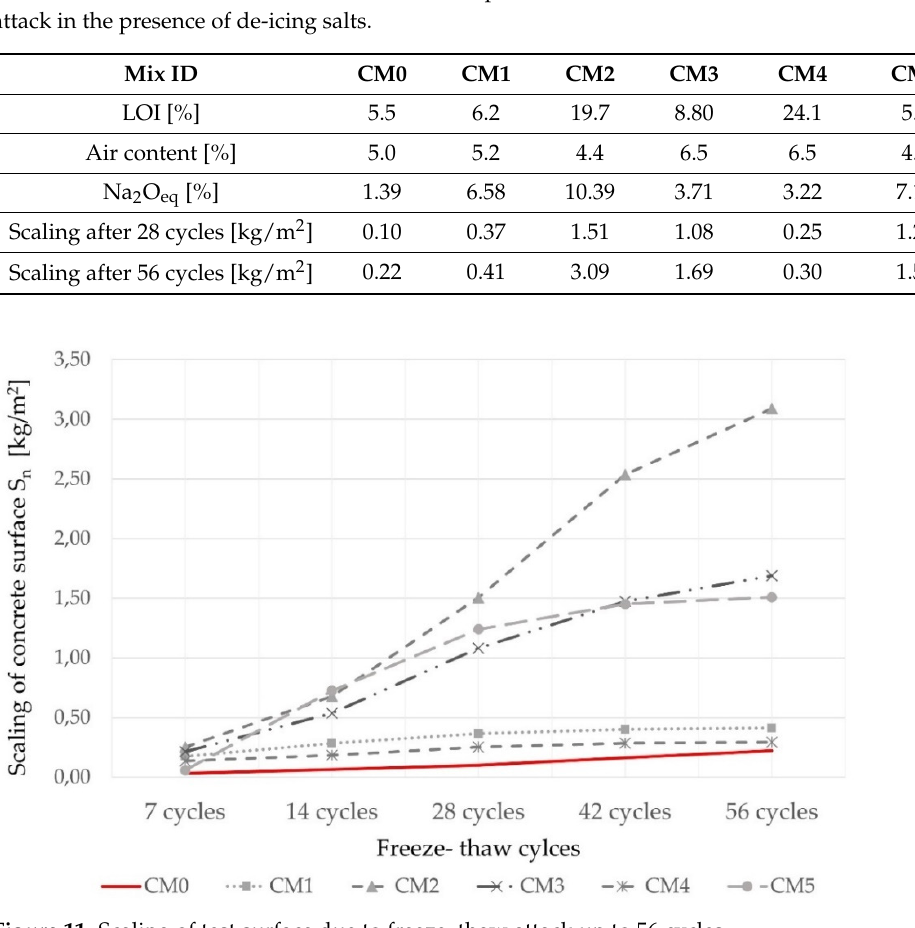
Figure 11. Scaling of test surface due to freeze–thaw attack up to 56 cycles. The specimen with WBA4, which had the highest LOI (24.10%) but also the highest air entrainment (6.5%), showed the least surface deterioration with a minimal mass of scaled material after 28 cycles (0.25 kg/m 2 ) and after 56 cycles (0.30 kg/m 2 ). For the CM3 mixture, it was not possible to determine which property of WBA had such a significant effect on the scaling of concrete. 3.4. Assessing Feasibility of WBA Implementation as SCM in a Large-Scale Industrial Environment Given the requirements of existing regulations in the concrete industry in Europe, i.e., the lack of standards for the use of WBA in construction products, one of the simplest and most promising ways of using WBA in construction products is covered by System 4 for assessment and verification of constancy of performance. According to Regulation (EU) No. 305/2011, the assessment and verification of the essential characteristics of con- struction products under System 4 is entirely carried out by the manufacturer, who must set up a factory production control system and self-declare the performance requirements for an authenticating product. With regard to placing concrete products containing WBA on the market, the reliability of the declaration of performance and, thus, the verification of each type of product containing WBA must be ensured. By superimposing the perfor- mance requirements given in compliance with the EN 1340 standard and the requirements imposed by the concrete manufacturer, the assessment of concrete mixtures with 15 wt% WBA was carried out to detect a fitting application for each WBA (Table 11). Table 11. Assessment recap of concrete mixes with WBA in relation to performance requirements. Concrete manufac- turer